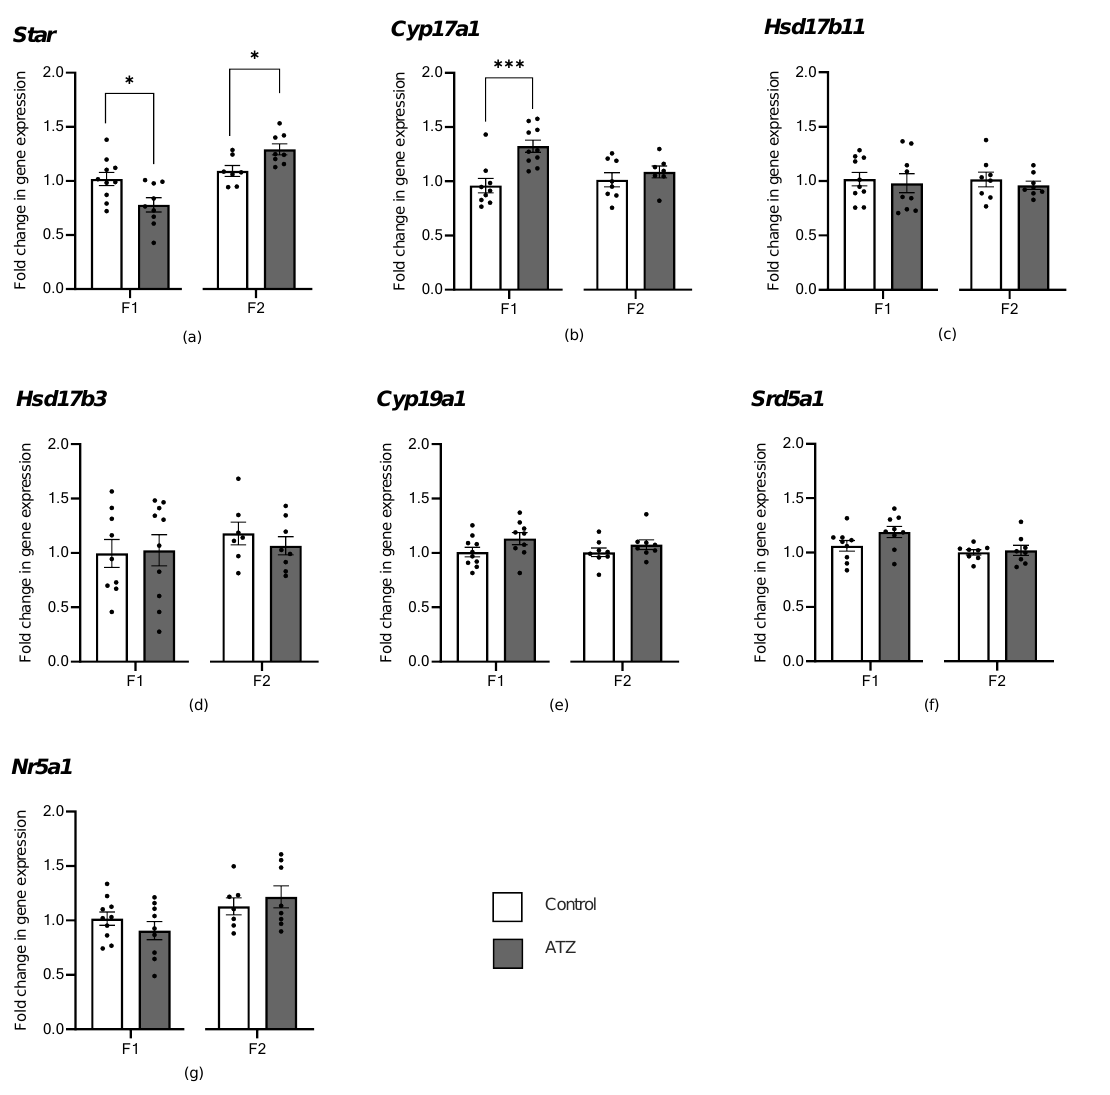
Figure 2. F1 and F2 testis gene expression assessed by qRT-PCR. ( a ) Star , Steroidogenic acute regulatory protein, ( b ) Cyp17a1 , Cytochrome P450 family 17, subfamily A member 1, ( c ) Hsd17 β 11 , Hydroxysteroid 17-beta dehydrogenase 11, ( d ) Hsd17 β 3 , Hydroxysteroid 17-beta dehydrogenase 3, ( e ) Cyp19a1 , Cytochrome P450 family 19, subfamily A member 1, ( f ) Srd5 α 1 , Steroid 5 alpha-reductase 1 and ( g ) Nr5a1 , Nuclear receptor subfamily 5 group A member 1 (SF-1). Genes were normalized to the geometric mean of B-actin , TBP , and Rlp19 . Results were represented as a fold change in gene expression relative to the control, using the Pfaffl method [46]. Data are means ± SEM. Significance between the control (n = 8–10) and ATZ (n = 8–10) is indicated by an asterisk (* p < 0.05 or *** p < 0.001). There were > 4 L per treatment, per generation.